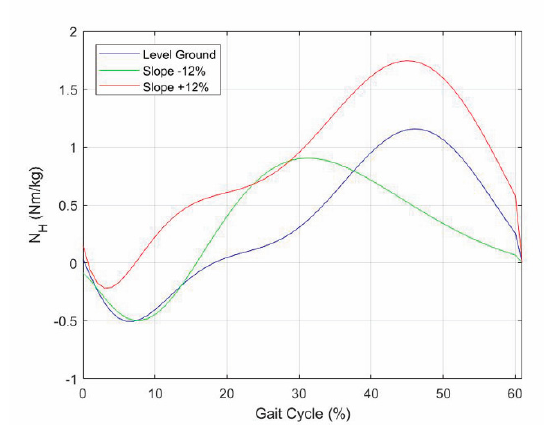
Figure 13. Internal torque, N H , of the hip that the patient must apply during the stance phase to walk with the prosthetic knee on walkways with three different longitudinal slopes.